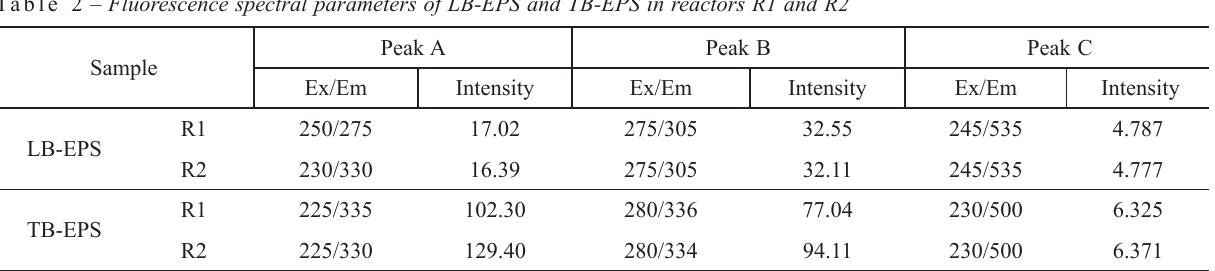
Table 2 – Fluorescence spectral parameters of LB-EPS and TB-EPS in reactors R1 and R2 Sample